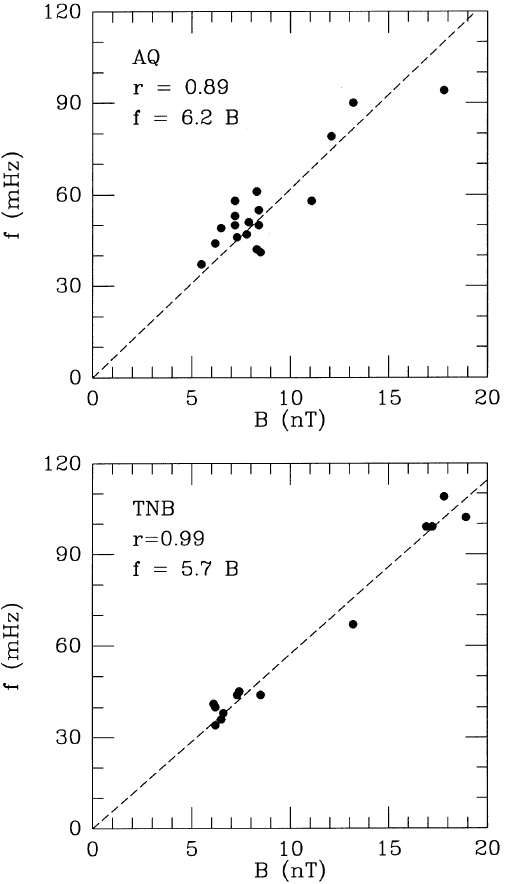
Fig. 4. Dependence of the frequency of selected Pc3 wave packets at AQ ( upper panel ) and TNB ( lower panel ) on the IMF strength. The dashed lines are the Fig. 5 (right side) the short, unique wave packet selected